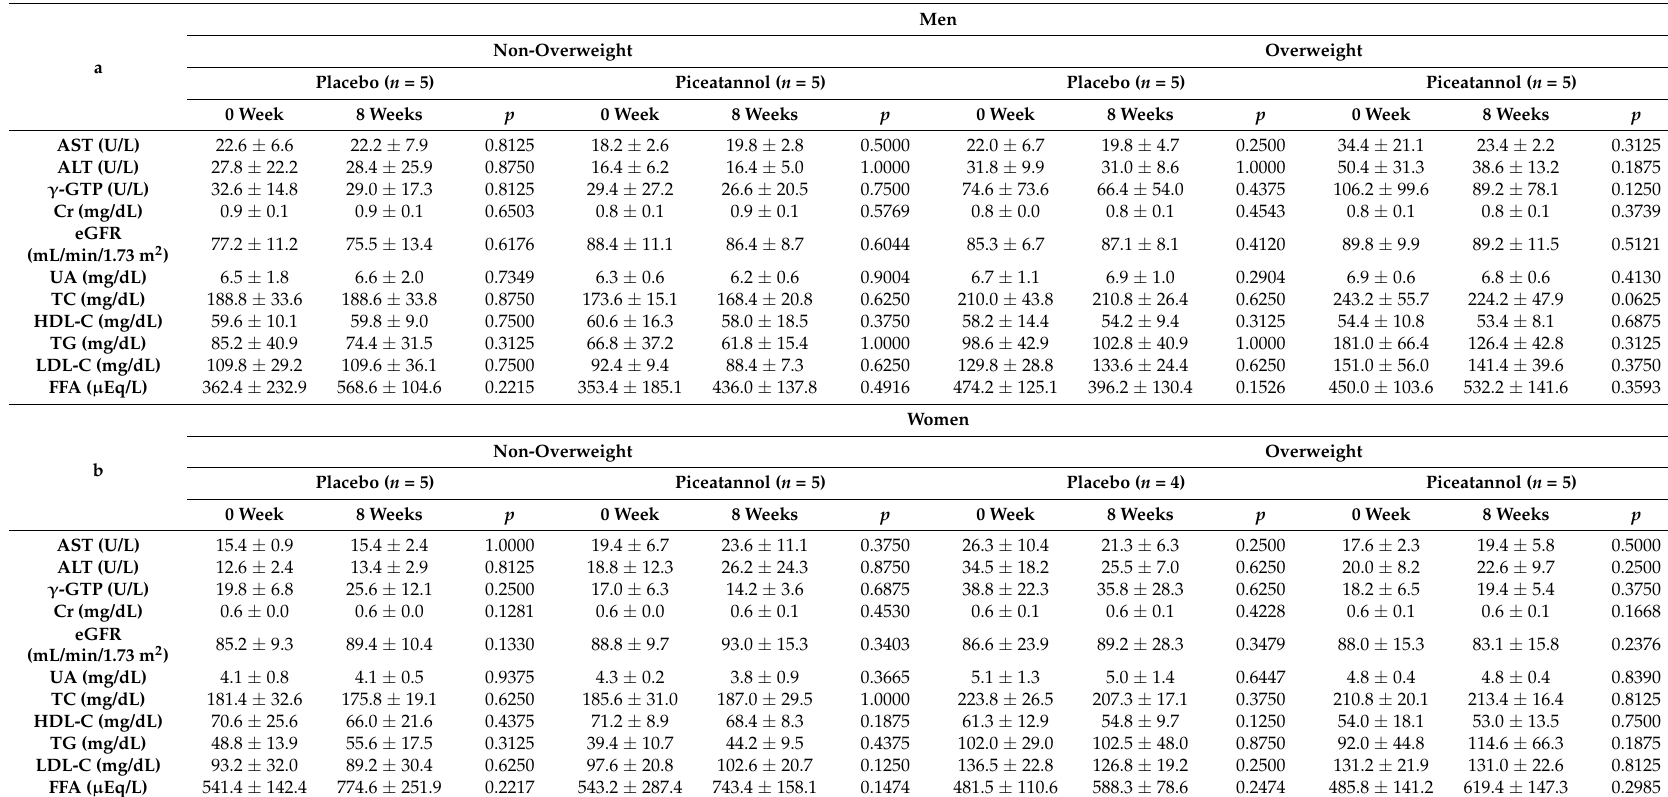
Table 4. Liver function tests, including aspartate aminotransferase (AST), alanine transaminase (ALT) and γ -glutamyl transpeptidase ( γ -GTP), and serum creatinine (Cr), estimated GFR (glomerular filtration rate), serum uric acid (UA), and lipid data, including total cholesterol (TC), high-density lipoprotein-cholesterol (HDL), low-density lipoprotein-cholesterol (LDL), triglycerides (TG) and free fatty acid (FFA) levels at baseline and after 8 weeks of placebo or piceatannol supplementation (a: men, b: